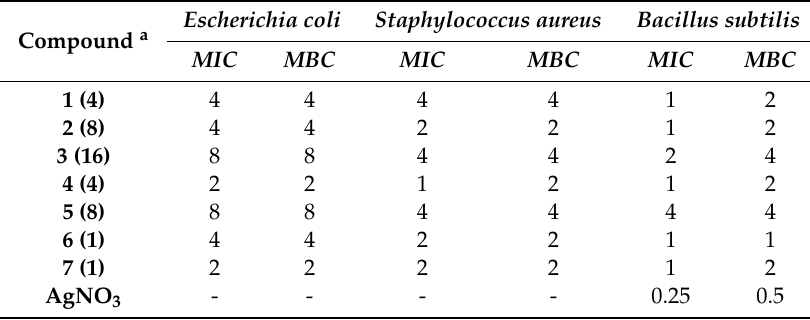
Table 3. MIC and MBC ( µ g / mL) values of the dendrimers ( 1 – 5 ) and dendrons ( 6 – 7 ) containing Ag(I)-NHC. Compound